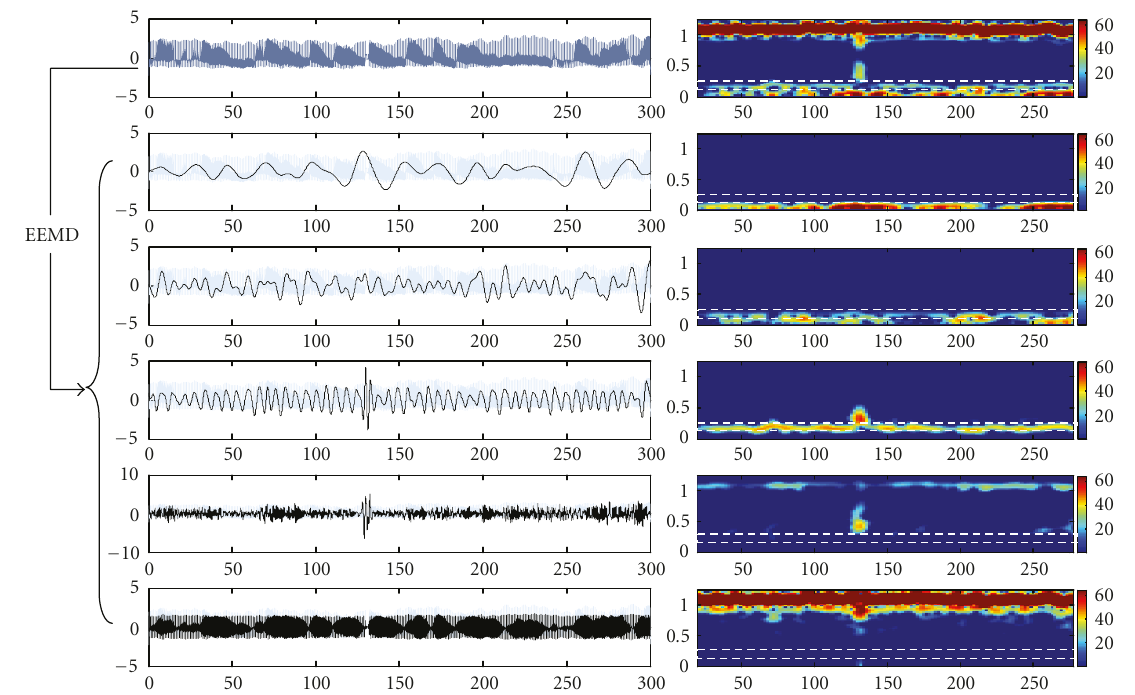
Figure 2: (Left panel) The same BP signal as shown in Figure 1 and its decomposed empirical modes (i.e., c 5 – c 9 components from bottom to top) obtained by the EEMD method. (Right panel) The corresponding short-time Fourier transform (STFT) spectrograms of the signals in left panel. The spectrograms were calculated and plotted using the same procedure discussed in Figure 1. The noise ratio for EEMD method is